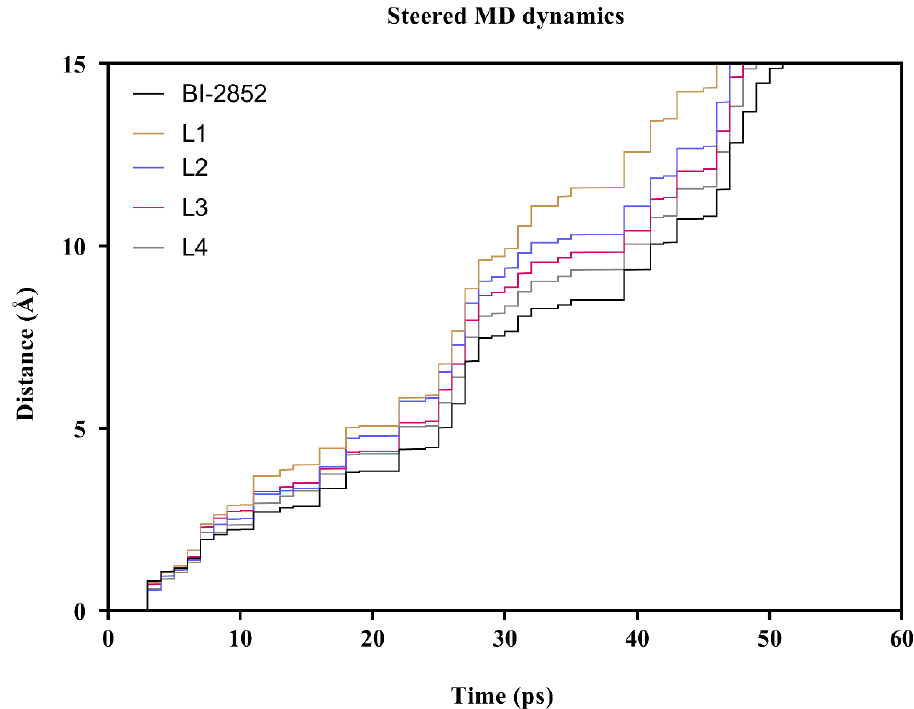
Figure 6. Dissociation of BI ‐ 2852 and lead flavonoids from the KRAS G12D mutant protein: the time taken (in picoseconds) to pull out the ligands, BI ‐ 2852 (reference compound), 5 ‐ Dehydroxyparato ‐ tein: the time taken (in picoseconds) to pull out the ligands, BI-2852 (reference compound), carpin K (L1), Carpachromene (L2), Sanggenone H (L3), and Kuwanol C (L4) from the KRAS G12D 5-Dehydroxyparatocarpin K (L1), Carpachromene (L2), Sanggenone H (L3), and Kuwanol C (L4) mutant protein’s center to 15 Å apart was calculated and their dissociation trajectories were repre ‐ from the KRAS G12D mutant protein’s center to 15 Å apart was calculated and their dissociation sented. trajectories were